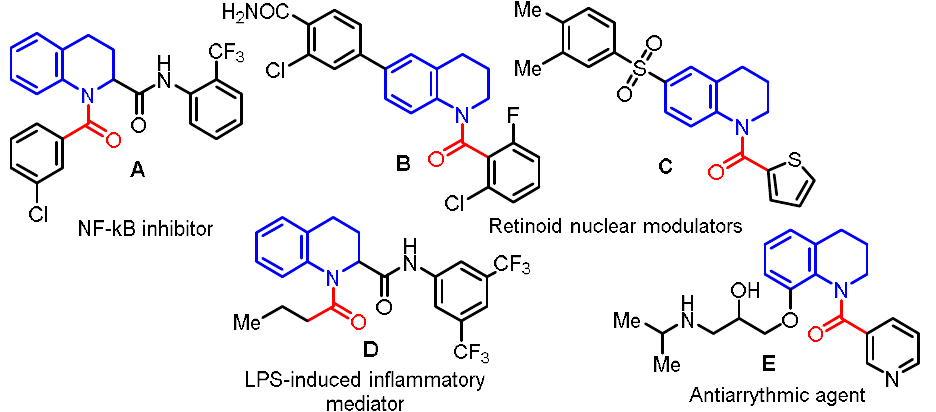
Figure 1. Structure of pharmacological agents based on the N -(tetrahydroquinolin-1-yl) amide skeleton.